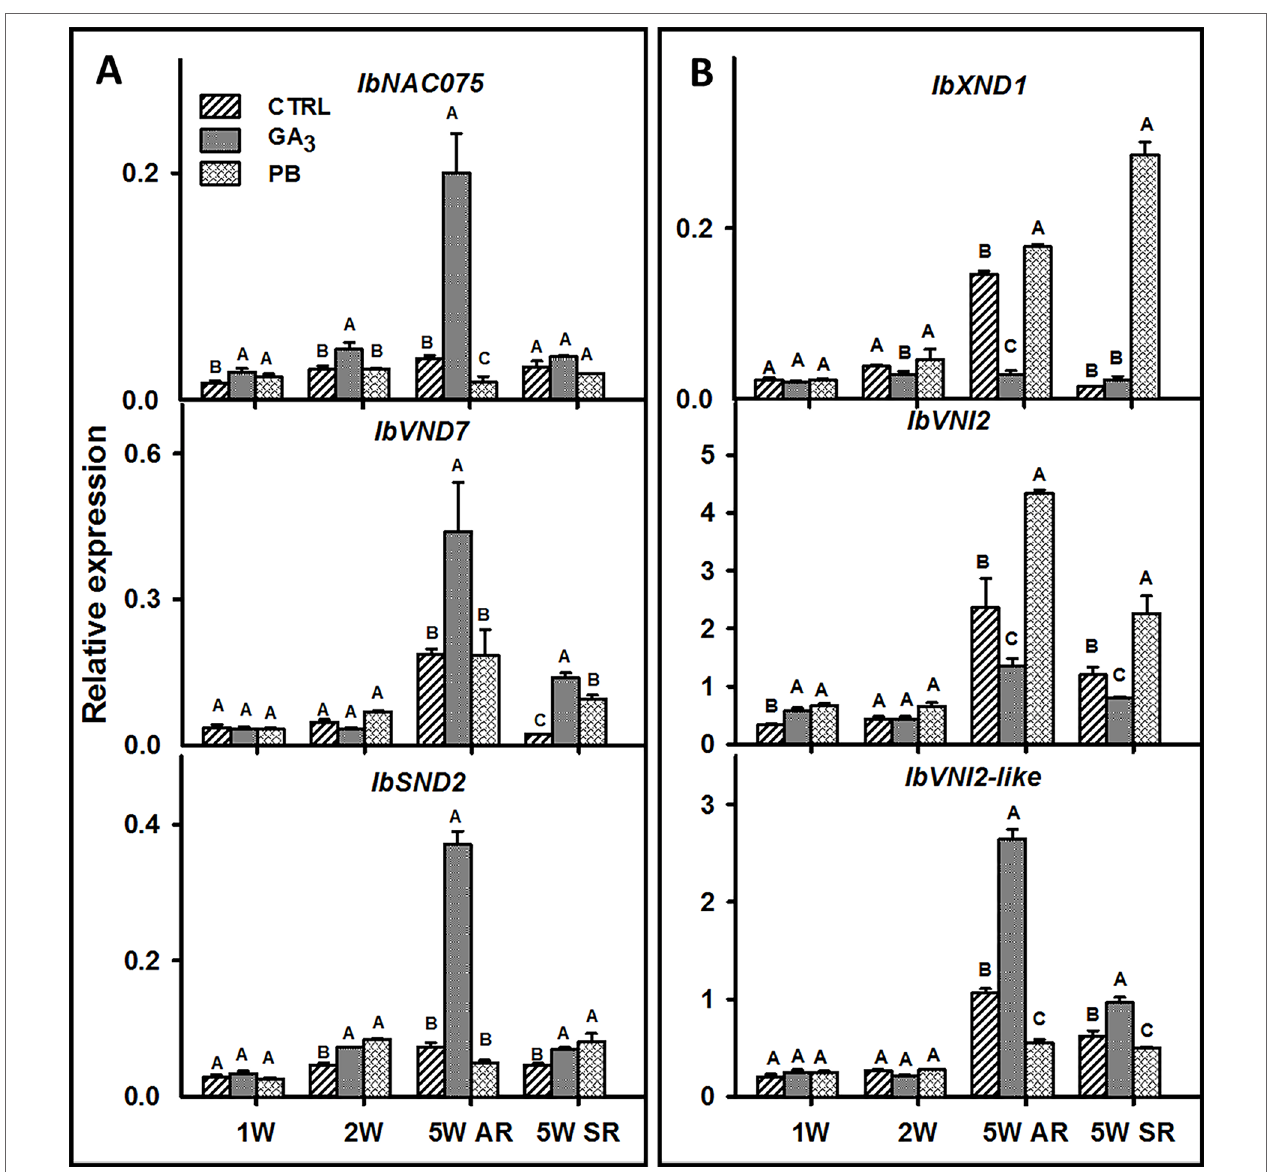
FiGURe 9 | The effect of GA 3 application on expression profiles of sweetpotato “ Georgia Jet ” potential positive (a) and negative (B) regulators of vascular development in adventitious roots (AR) and storage-roots (SR). Expression/transcript levels were measured at 1W, 2W, and 5W after planting for AR and at 5W for SR, using qRT-PCR analyses, and values were normalized relative to the expression levels of phospholipase D1a. qRT-PCR data are mean (± SE) of three independent biological replicates (each representing roots pooled from four plants). Significance analysis was performed by using student’s t-test ( P ≤ 0.05 ), where unlike letters represent significant differences between treatments within a group. Control (treated with water); GA 3 , application of 50 ppm gibberellic acid 3 for two weeks; PB, application of 5 ppm paclobutrazol for two weeks.